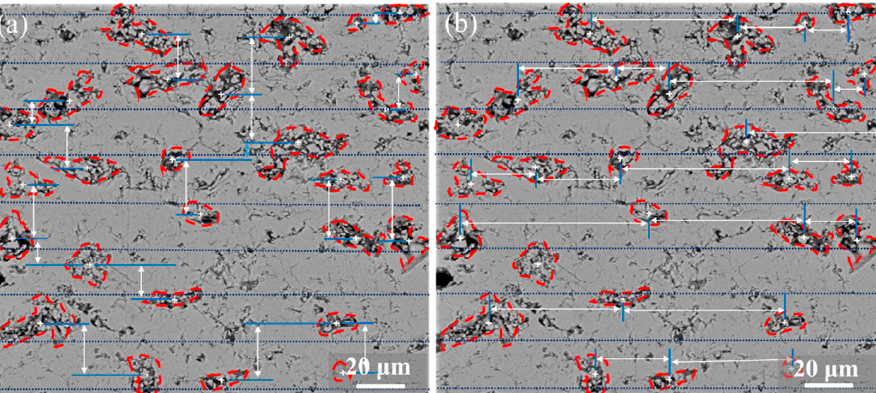
Figure 5. Schematic diagrams showing the method used to measure the distribution distance of the particles embedded in the matrix coating: ( a ) vertical distance and ( b ) horizontal distance.